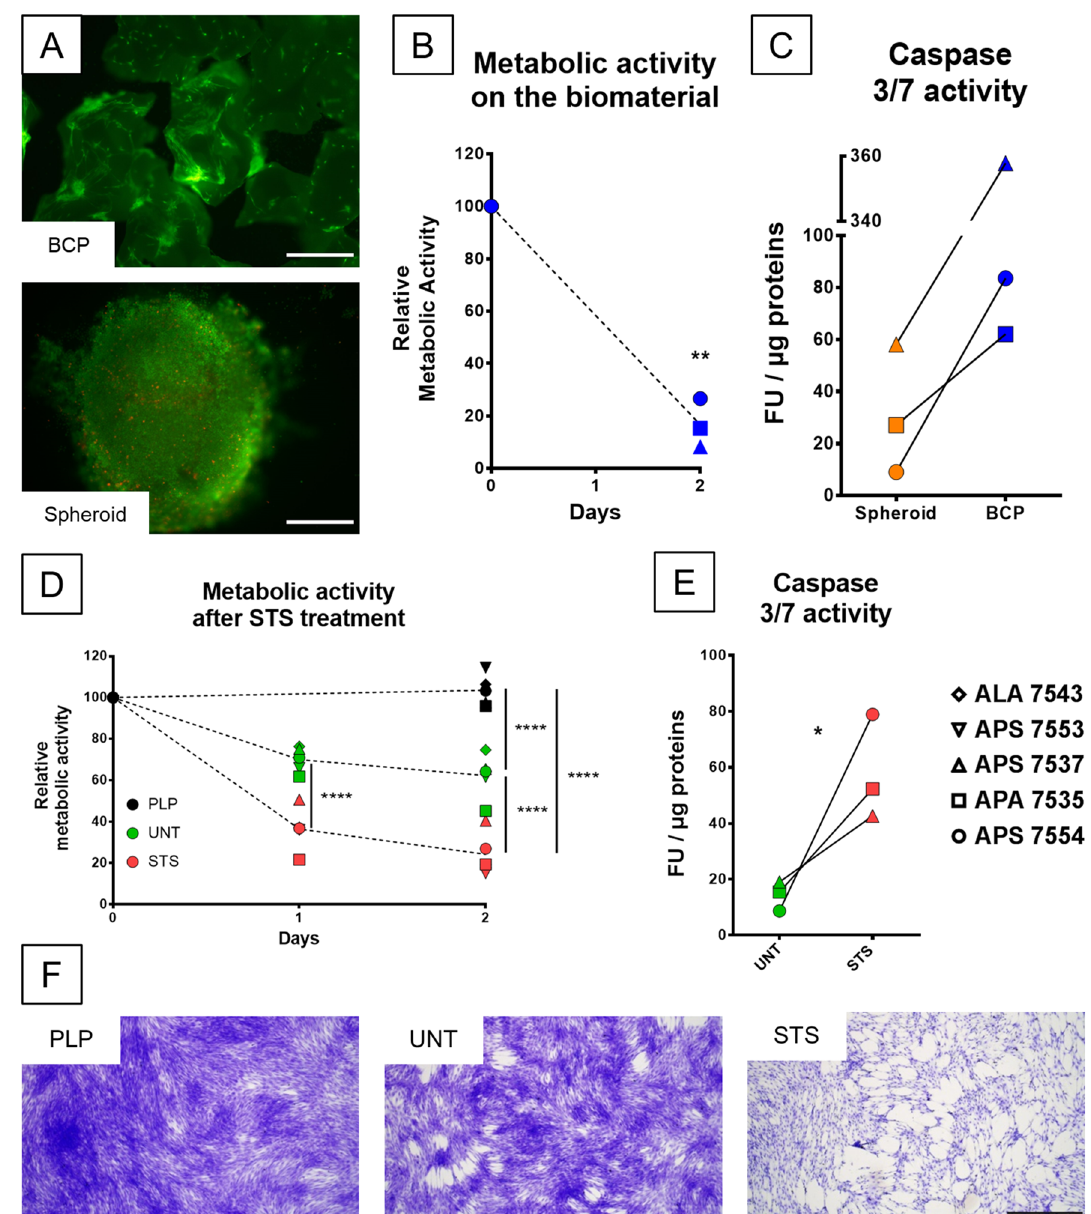
Figure 2. MSCs seeded on BCP material undergo apoptosis, reproduced in 2D by a staurosporine treatment. ( A ) LIVE/DEAD® staining at 48 h of MSCs seeded on BCP particles or in spheroid form. ( B ) Viability measure by resazurin assay after 48 h of MSCs from three donors on the BCP material, normalized to the value after seeding. N = 3 independent experiments with technical triplicate. Statistical analysis by one-sided paired t-test, ** for p value < 0.01 ( C ) Caspase 3/7 activity per µg of proteins extracted from spheroid or BCP cultures of three MSC donors. N = 3 independent experiments with technical triplicate. ( D ) Viability measure by resazurin assay after 24 and 48 h of MSCs from five donors, in complete media (PLP) in serum-free media (untreated, UNT) or in serum-free media after a 4 h 0.1 µM STS treatment (STS), normalized to the value before treatment. N = 5 independent experiments with technical triplicate. Statistical analysis by repeated measure ANOVA followed by Tukey’s multiple comparison test, **** for p value < 0.0001. ( E ) Caspase 3/7 activity per µg of proteins extracted from untreated (UNT) or STS-treated (STS) cultures of three MSC donors. N = 3 independent experiments with technical triplicate. Statistical analysis by one-sided paired t-test, * for p value < 0.05. (F) Crystal violet staining of MSCs after 48 h in complete media (PLP), serum-free media (UNT) or serum-free media after STS-treatment